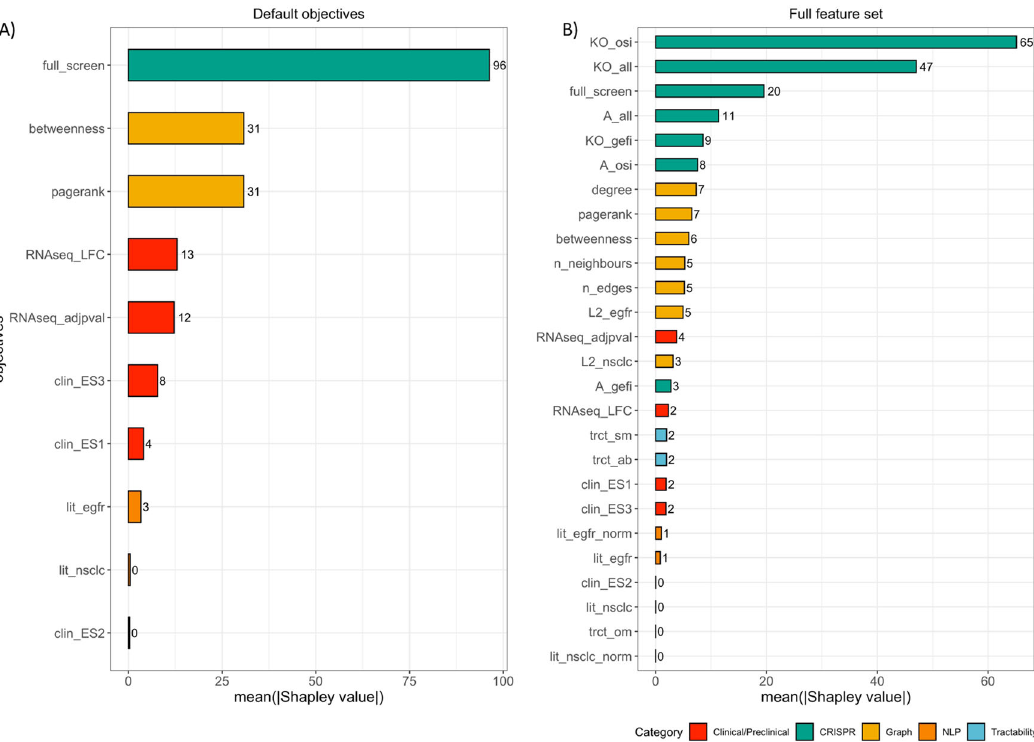
Fig. 4 Shapley values re fl ect relative importance of features that differentiate relevant hits from non-relevant. We modeled the task as a binary classi fi cation problem, where a gene can be labeled as either relevant or not. A list of genes prioritized by domain experts for secondary screens was used as a set of labels. The analysis was run using A a set of default objectives; B similar analysis repeated on the full set of objectives. In both cases features associated with consistency in CRISPR screens appear to have the greatest impact on classi fi cation, closely followed by graph-derived